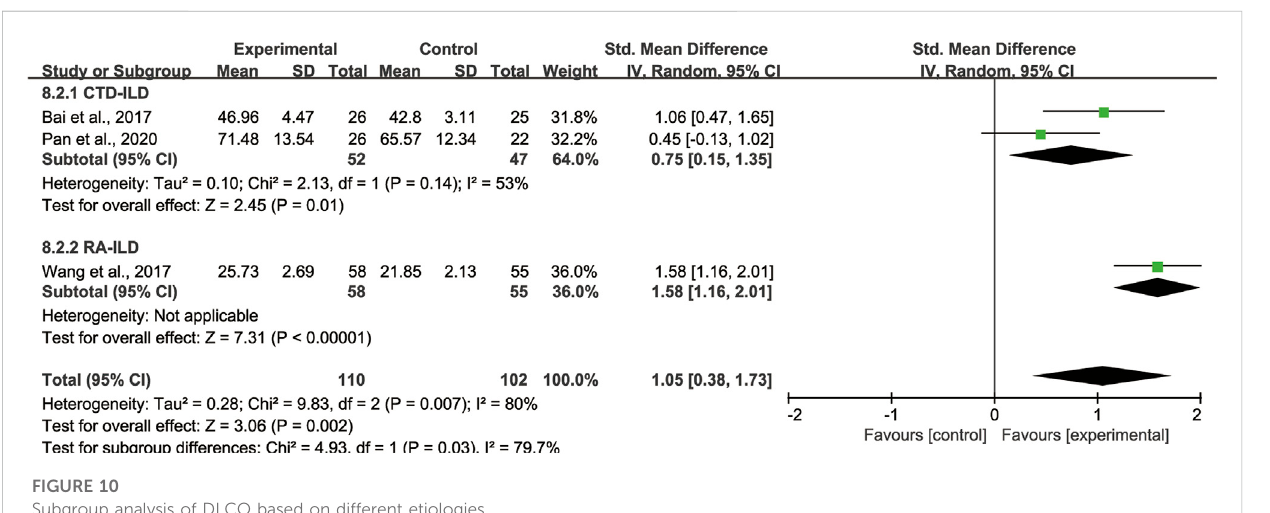
FIGURE 10 Subgroup analysis of DLCO based on different